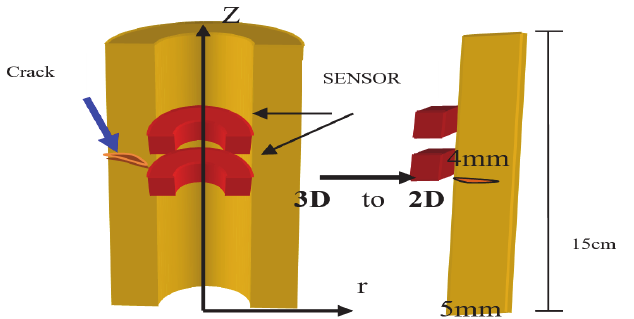
Figure 1: Sensor-Tube geometrical